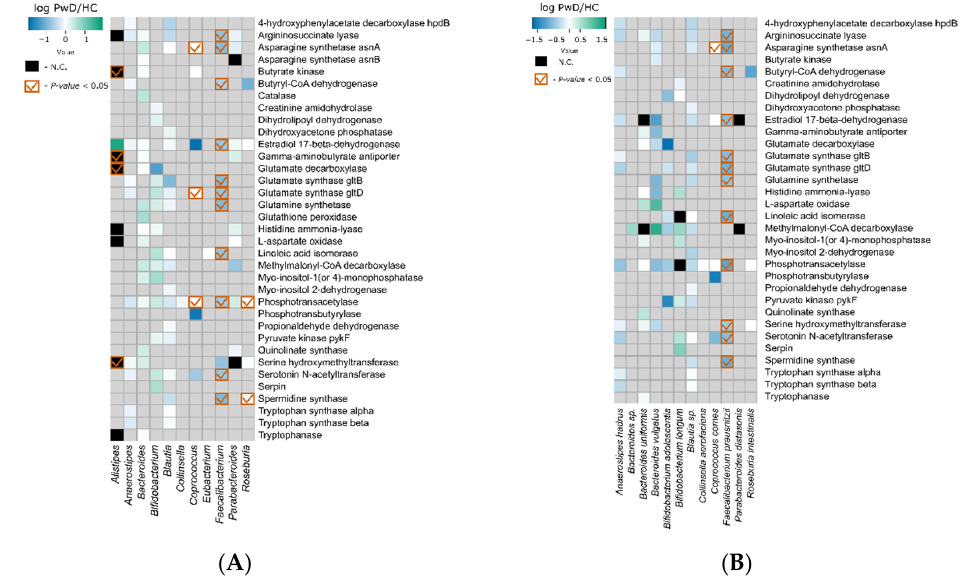
Figure 4. Metagenomic signatures describing changes in GM of patients with MDD at the ( A ) ‘Genus’ and ( B ) ‘Species’ taxonomic levels. Only signature pairs identified in the 46 most common bacterial genera (and corresponding species) of the human GM and found in more than 50% of the samples are presented. The color gradient represents the logarithm of ratios of median abundances in the PwD and HC groups. The green color gradient describes the increase in abundances of the signature pairs, and the blue color describes the decrease in abundances. The ‘N.C.’ values (colored in black) represent non-countable ratios, where the median abundance in the HC group was 0. The white color represents ratios where the median value in the PwD group was 0 (logarithm is undefined). Signature pairs with statistically significant changes in abundances are indicated with a red tick. More detailed information is provided in Supplementary Tables S6a,b.